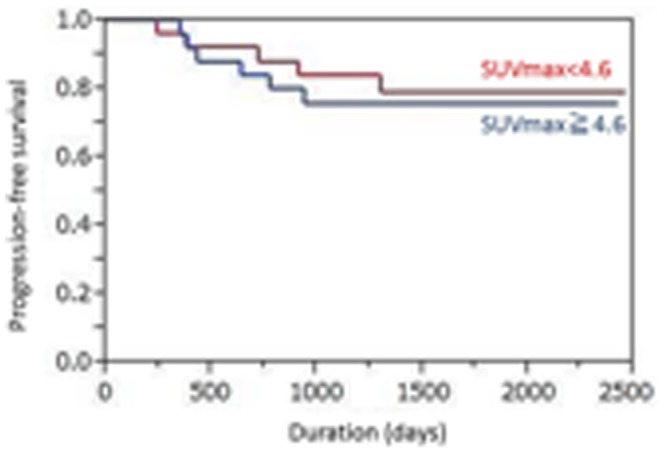
The high SUVmax (≧4.6) subgroup showed a slightly shorter median progression-free survival time than the low SUVmax (<4.6) subgroup (42.7 vs. 57.3 months; p = 0.66).